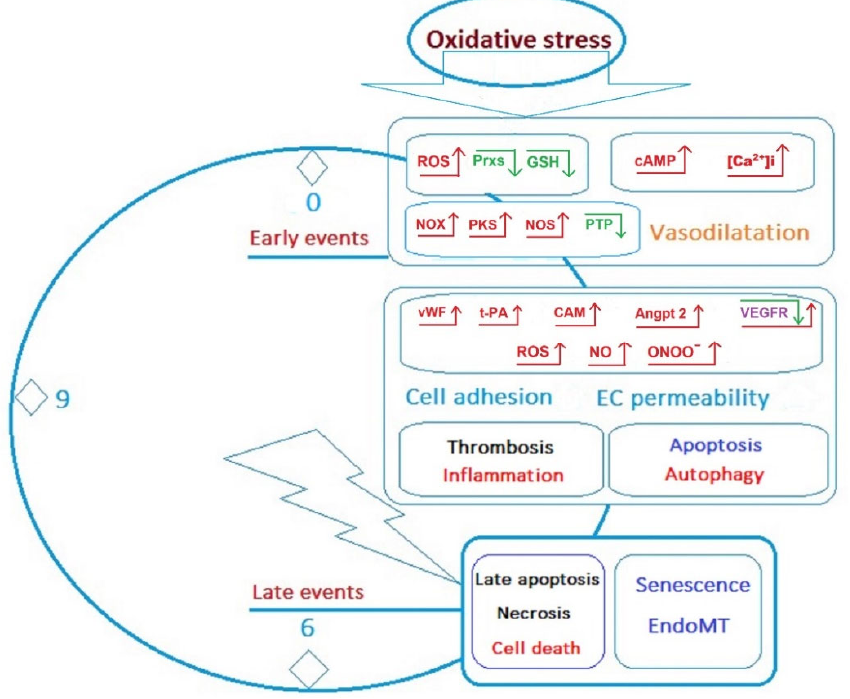
Figure 5. Early and late events developed in ECs upon the influence of oxidative stress. Early changes in EC under the influence of oxidative stress and increased ROS involve a cascade of biochemical reactions leading to the development of vasodilation. In the longer term, especially under conditions of chronic oxidative stress, there is an increase in cell adhesion and endothelial permeability disorders, eventually leading to induction of cell senescence and/or endothelial to mesenchymal transition (EndoMT), apoptosis, development of inflammatory/necrotic processes, and cell death. ↑ —increase; ↓ —decrease.